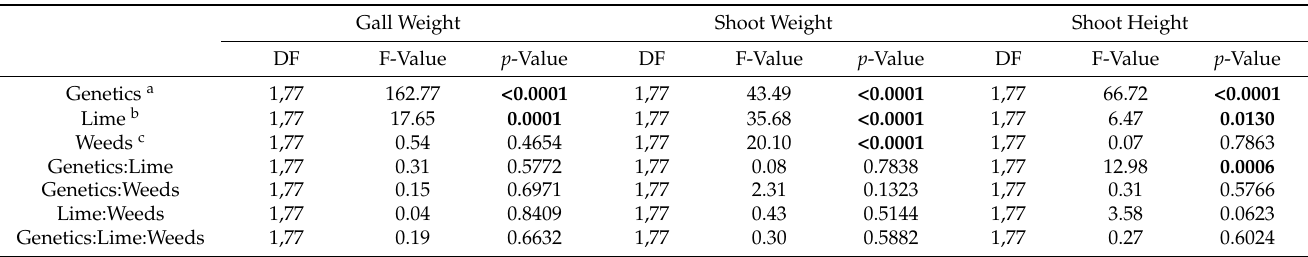
Table 1. Three-way ANOVA with REML mixed-model analysis for field trials evaluating the effects of clubroot resistance, soil liming and weed control for the management of Plasmodiophora brassi- cae on canola at three naturally infested field sites in Edmonton, AB, Canada, in 2018 and 2019; p -values < 0.05 are in